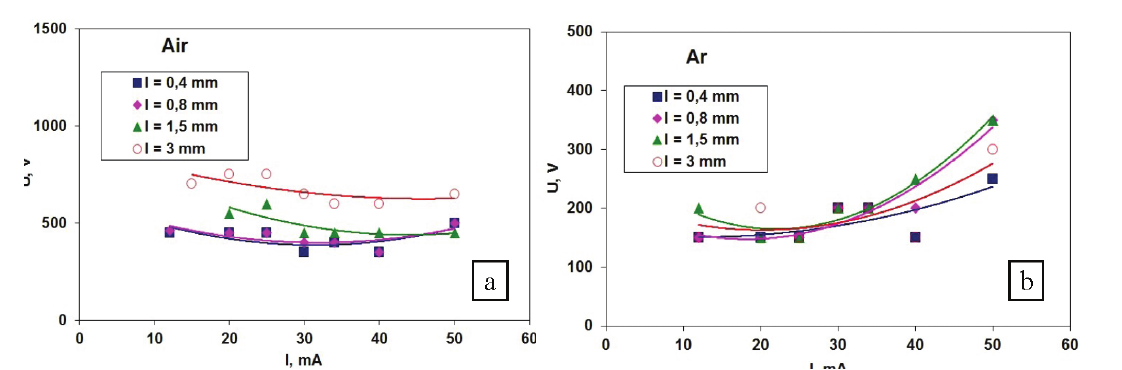
Figure 5: The CVC of the microdischarge with a vortex gas flow at negative polarity of the flat electrode with gas outlet of 0.5 mm in diameter for diff erent working gases: а) air; b) argon. Gas flow is G = 1 L min -1